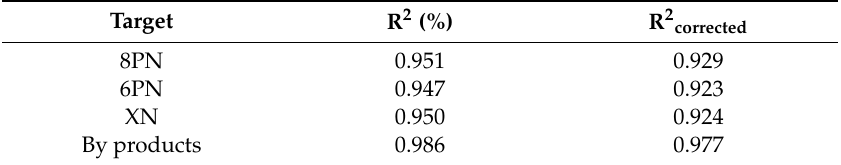
Table 2. Coefficient of determination R 2 and corrected coefficient of determination R 2 corrected concerning the targets.